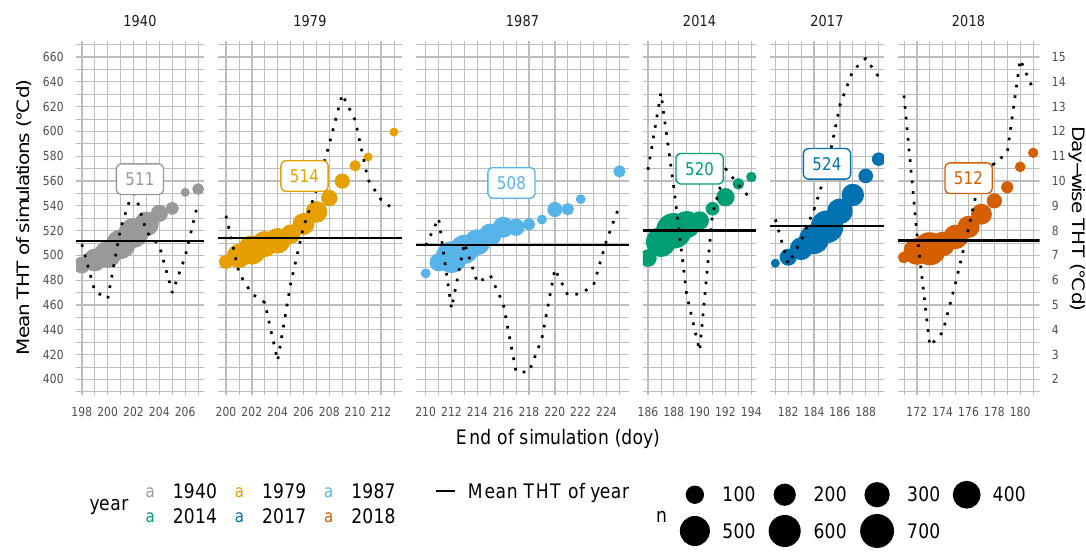
Figure 14. Variability in end of simulation date (DOY) with average accumulated THT per end-date and per year, plus daily THT contributions of adjacent